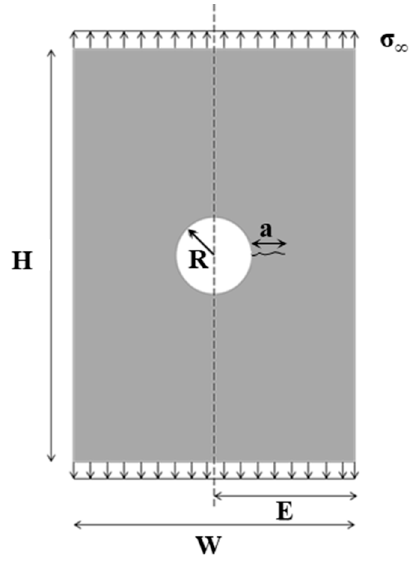
Figure 3. Dimensions considered for the 2D stress intensity factor (SIF) analytical solution.